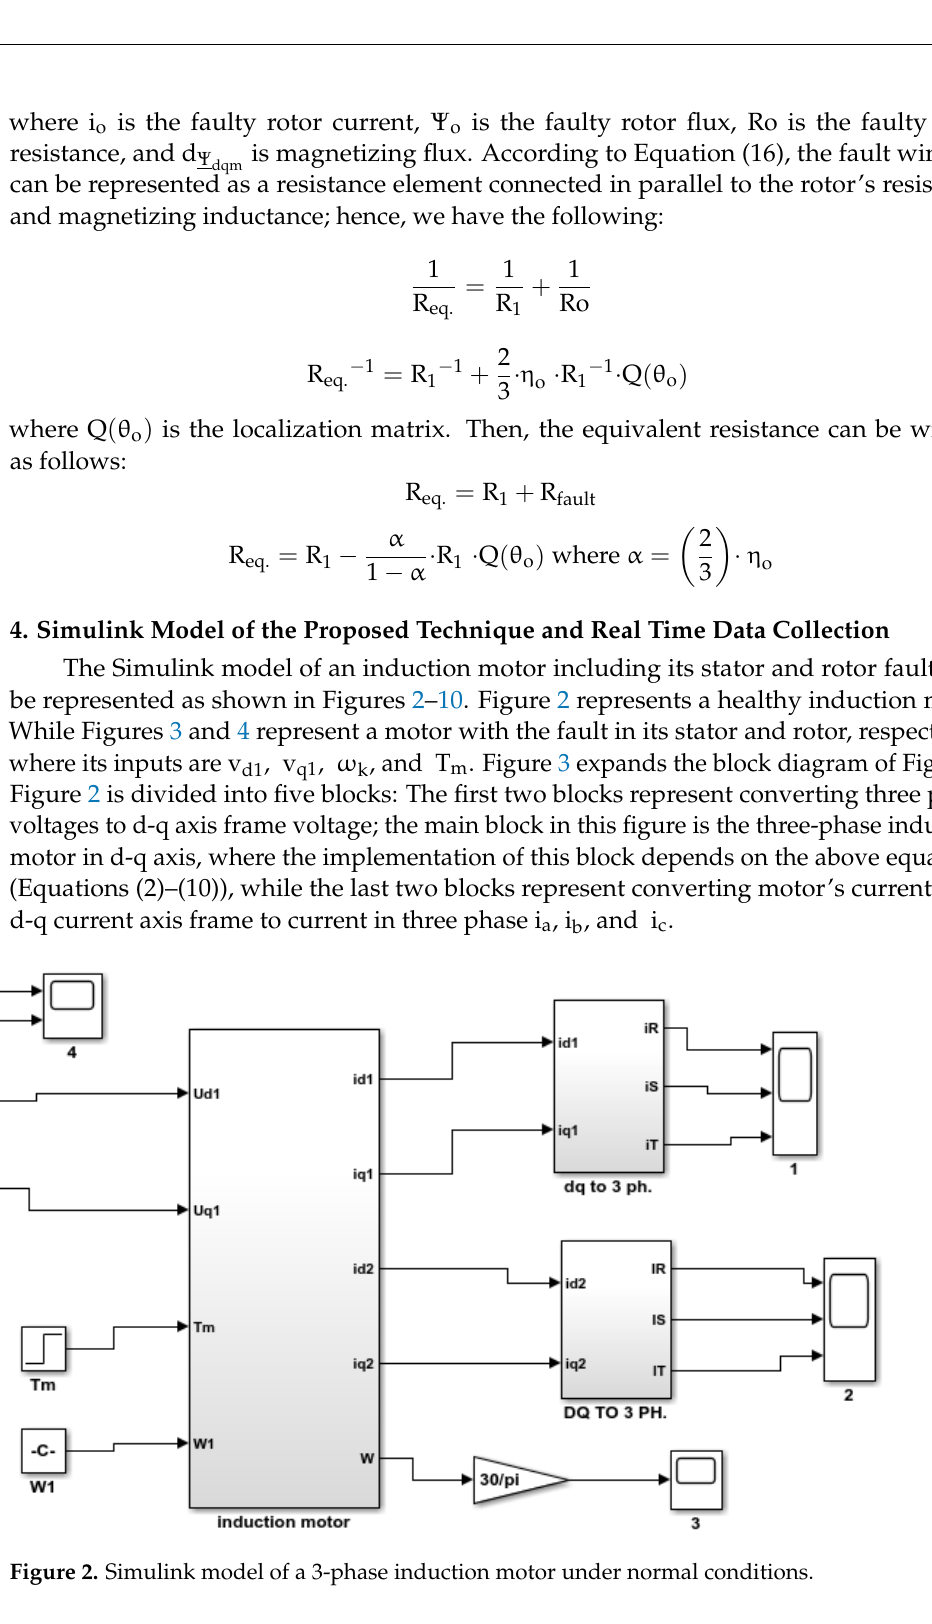
Figure 3. Sub-block of a 3-phase induction motor in d-q axis. The Simulink model of an induction motor with faults in its stator can be imple- mented in MATLAB Simulink, as shown in Figure 4. This figure represents the MATLAB Simulink implementation of inter-turn stator faults block. Figure 5 shows the sub-block of the stator faults, which is implemented based on Equations (11)–(13), while Figure 4 rep- resents a healthy induction motor, as shown in Figure 2. Adding the inter-turn stator fault block, which is implemented in Figure 5, has been performed according to Equation (14), where Equation (14) represents the normal stator current combined with current that re- sults from a stator’s fault. The Simulink model of the induction motor with rotor faults can be implemented in MATLAB Simulink, as shown in Figure 6. Like stator faults, rotor